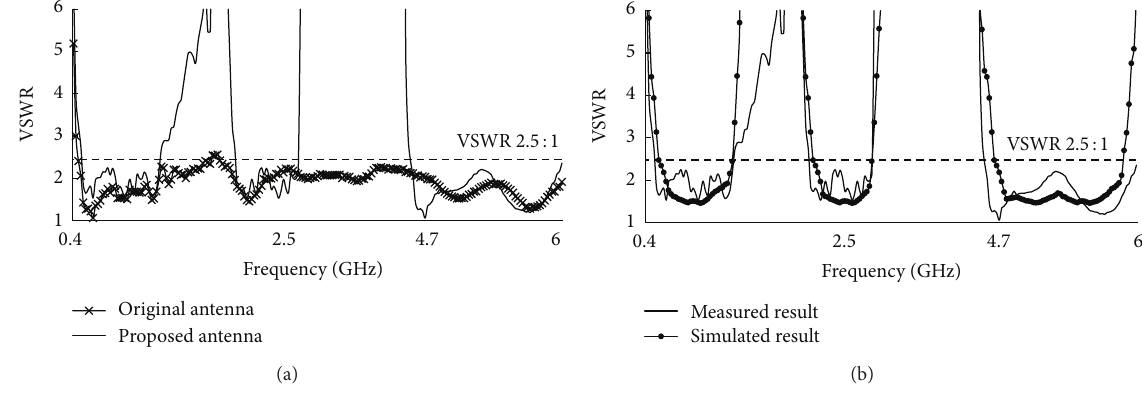
Figure 2: (a) Measured VSWR against frequency of the original and proposed antenna. (b) Measured and simulated VSWR against frequency of the proposed